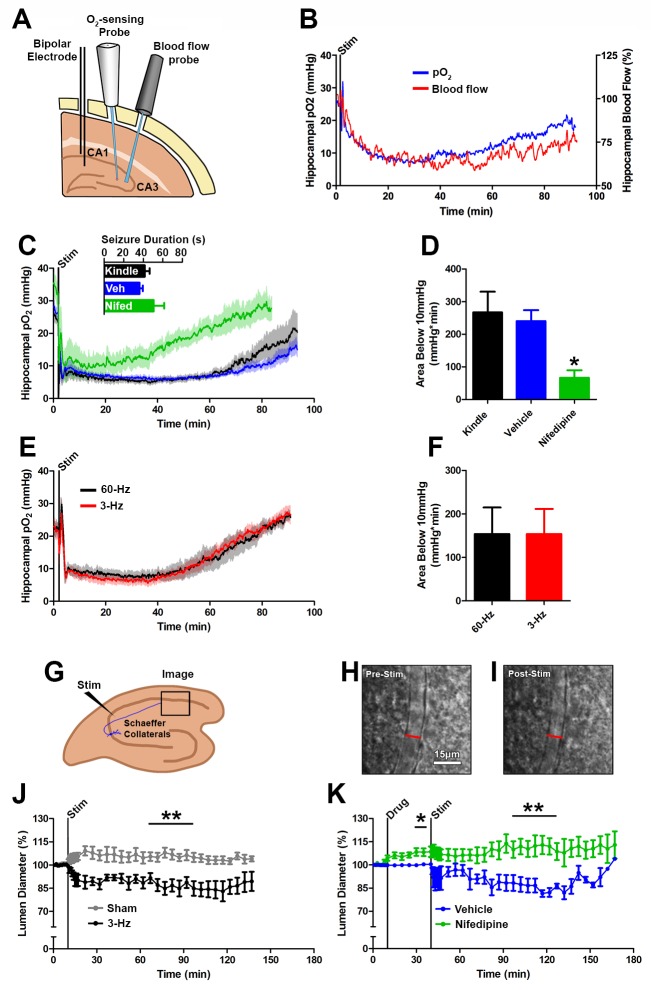
Seizures cause postictal vessel constriction in an in vitro preparation and reduced blood flow (hypoperfusion) in vivo.(A) Location of implants for simultaneous blood flow and pO2 recordings. These two probes were placed at opposing angles to leave room for cable attachment. (B) The simultaneous measurement of mean blood flow and mean pO2 in the hippocampus following brief seizures (n = 5). (C) Nifedipine pre-treatment (15 mg/kg) caused an elevation of baseline pO2, inhibited severe hypoxia, and increased the rate of recovery (n = 5). Inset reveals no difference in seizure duration. (D) Quantification of (C). Nifedipine pre-treatment reduced the amount of severe hypoxia (area below 10mmHg). *p<0.05 (within-subject ANOVA). (E) Validation of 3 Hz stimulation in young rats (P28–P35). Mean oxygen profiles following standard kindling and 3 Hz stimulation (n = 6). (F) Quantification of (E). No significant differences were found in the amount of severe of hypoxia (area below 10 mmHg). (G) Acute hippocampal in vitro slice preparation for measuring postictal vessel constriction. 3 Hz stimulation was applied to the Schaeffer collaterals and imaging was captured in stratum radiatum of CA1. (H,I) Representative images of CA1 arteriole pre-stimulation (H) and post-stimulation (I). Scale bar for (H) and (I) is 15 µm. (J) Lumen diameter over time in stimulated and sham controls. Mean lumen diameter is reduced following 3 Hz stimulation (n = 11) relative to sham (n = 8) between 60 and 90 min post-stim. Data displayed as mean ± SEM. **p=0.001 (t-test). (K) 30 min following nifedipine (50 µM; n = 7) or vehicle (n = 5) application slices were stimulated. Mean lumen diameter was significantly different between 60 and 90 min post-stim. **p<0.01.